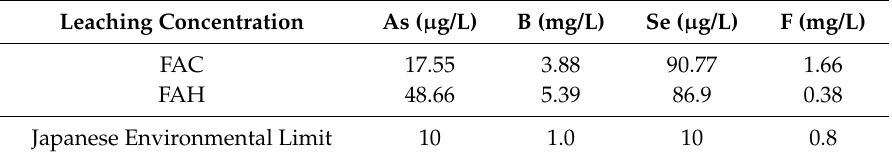
Table 3. Trace element leachate concentrations in coal fly ashes without